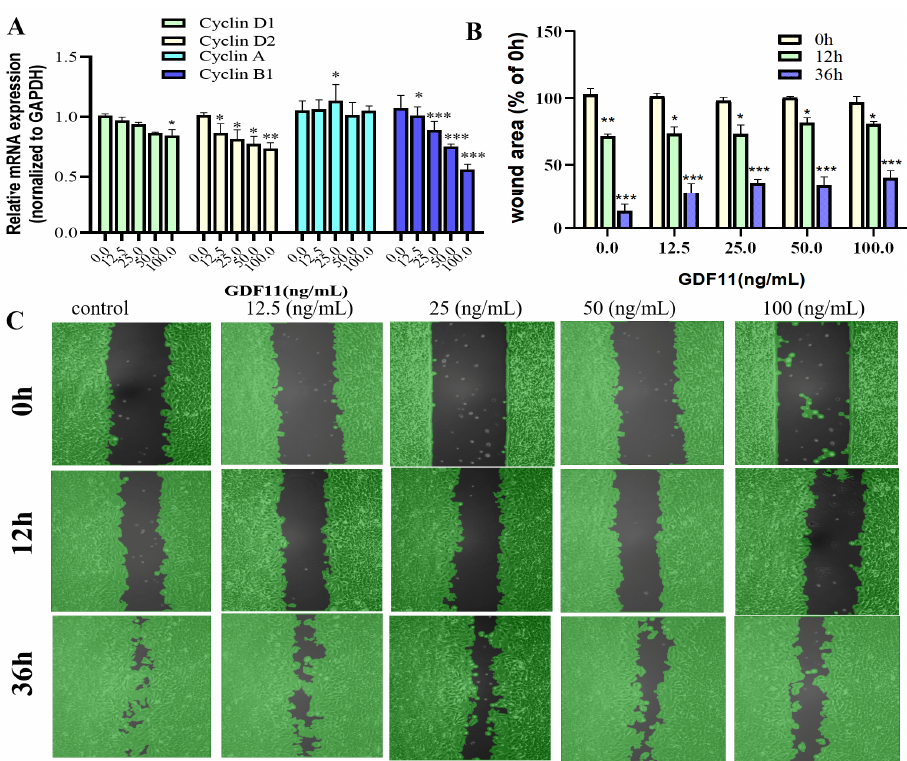
Figure 3. Effects of GDF11 on migration and cell cycle-related proteins. ( A ) The mRNA levels of cell cycle-related proteins (Cyclin D1, D2, A and B1) when PC12 cells were treated with GDF11 or vehicle (control) for 5 h. ( B ) Quantitative analysis of migration as in ( C ). ( C ) Wound healing / migration was monitored over time by an Ibidi Culture-Insert. Black in each graph represented as the wound area. * p < 0.05, ** p < 0.01, *** p < 0.001.